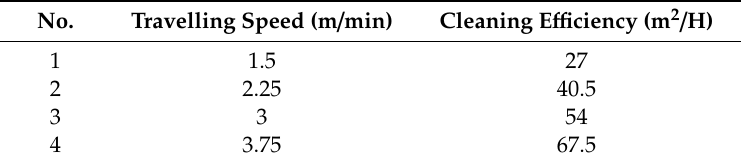
Table 1. Relationship between travelling speed and cleaning e ffi ciency.